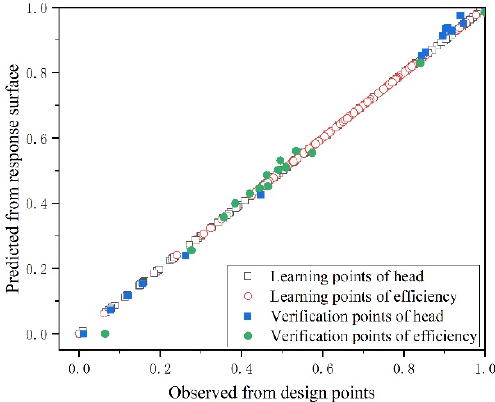
Figure 7. Convergence curves for the Sparse Grid approximation model.